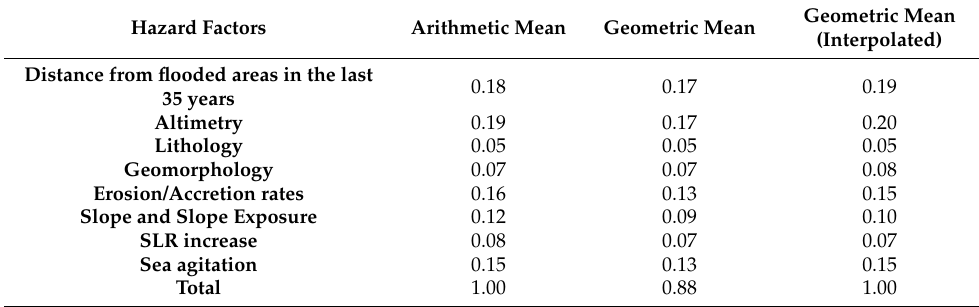
Table 17. Arithmetic mean, geometric mean, and interpolated geometric mean from the weighting of the hazard criteria, carried out by the consulted